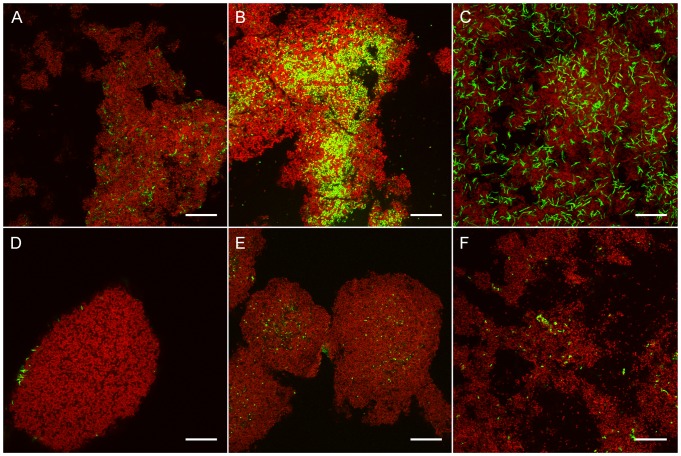
Biofilms grown in the presence of OPN, hybridized with EUB338 and species-specific probes SMIT, SSAN, ANAES, SDOW or SORA2.EUB338 targets all organisms in the biofilms and was labelled with Atto633 (red). Species-specific probes were labelled with Cy3 (green). A.
S. mitis SK24, the dominant organism in biofilms grown without OPN, accounted for 14% of the bacterial biovolume. B–F. The relative biovolumes of all other organisms increased in biofilms grown with OPN, as compared to biofilms grown without OPN. S. sanguinis SK150 (B) was the most abundant organism in the biofilms (48% of the biovolume). A. naeslundii AK6 was a prominent colonizer in basal layers of the biofilms (C, 22% of the biovolume in the basal layer), but was detected less frequently in upper layers of the biofilm (D, 9% of the total biovolume). S. downei HG594 (E, 11% of the biovolume) and S. oralis SK248 (F, 3% of the biovolume) represented smaller fractions of the bacterial biofilm.